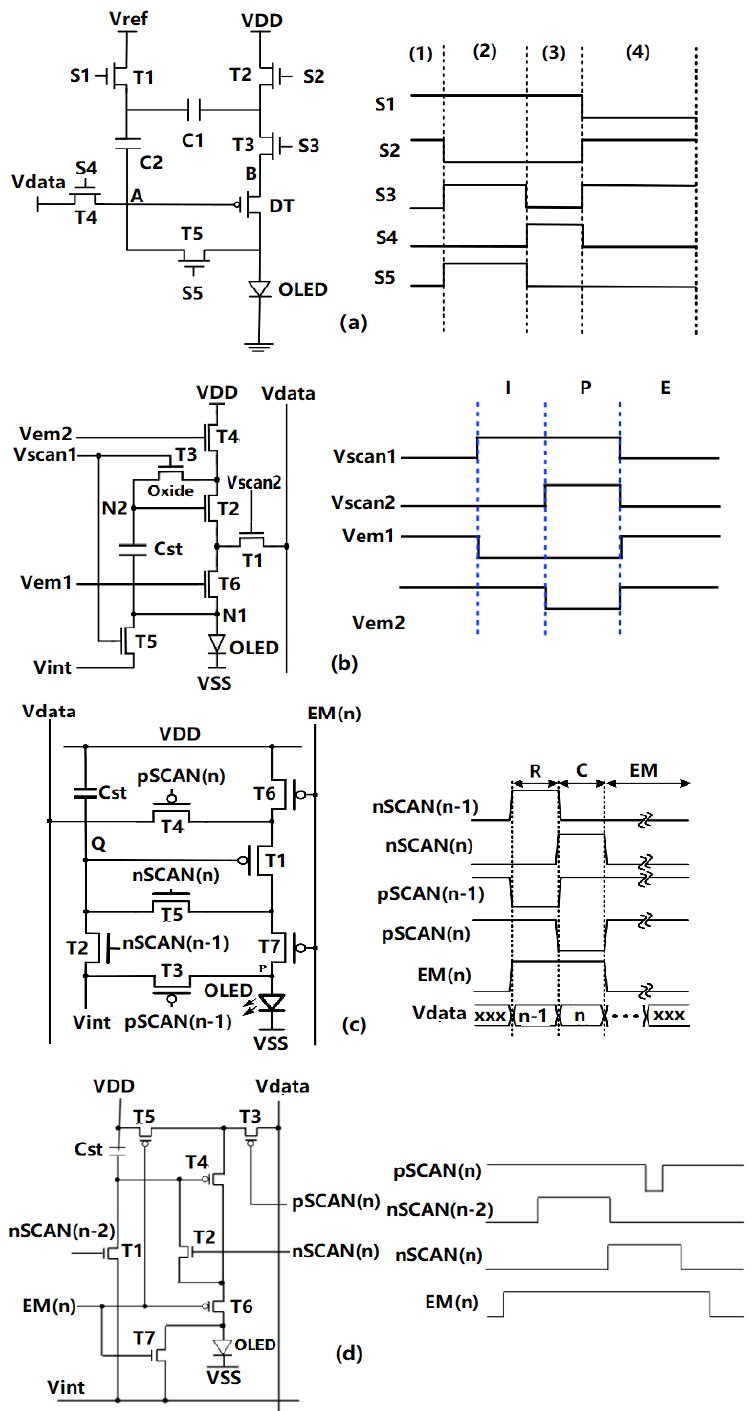
Figure 8. Four kinds of LTPO pixel circuits: ( a ) 6T2C with one driving LPTS TFT [142] (Reprinted with permission from Ref. [142]. Copyright 2022 John Wiley and Sons), ( b ) 6T1C with one oxide TFT [141] (Reprinted with permission from Ref. [141]. Copyright 2022 John Wiley and Sons), ( c ) 7T1C with one oxide TFT [143] (Reprinted with permission from Ref. [143]. Copyright 2022 John Wiley and Sons), and ( d ) 7T1C with three oxide TFTs [144] (Reprinted with permission from Ref.